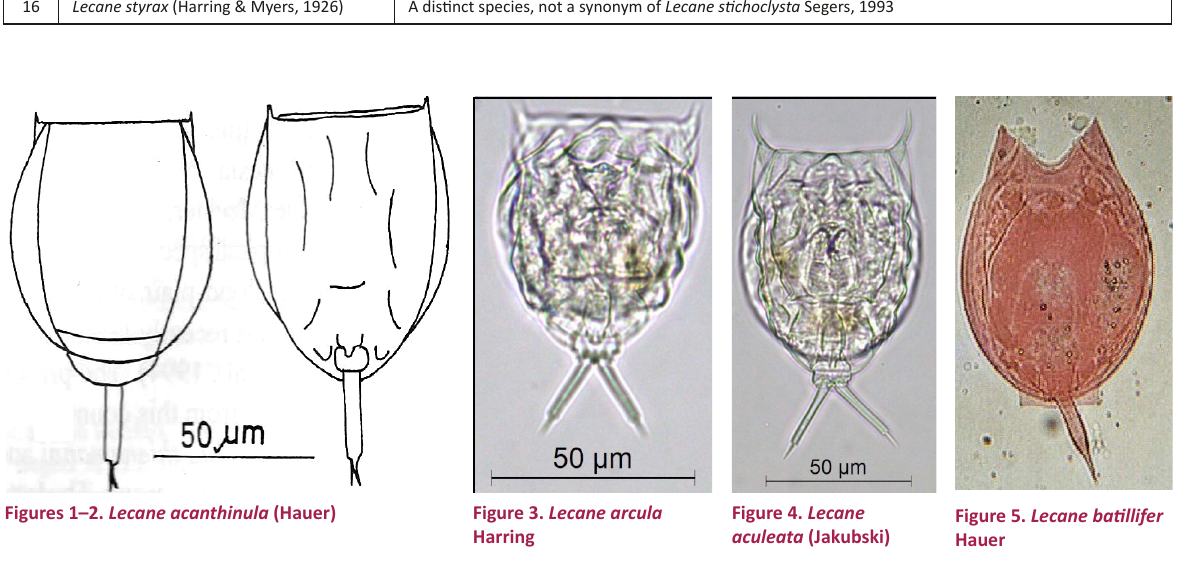
Figure 5. Lecane batillifer